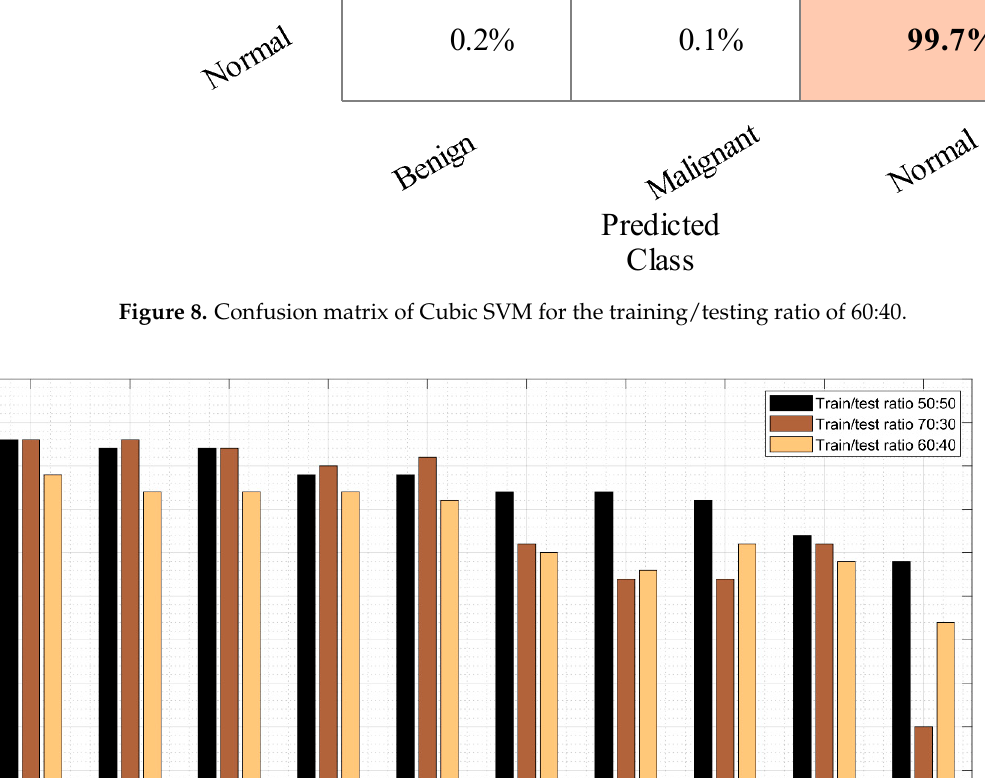
Figure 9. Summary of DarkNet53 classification accuracy using different training/testing ratios. Table 5 presents the results of the fourth experiment. In this experiment, a 50:50 training/testing ratio is used. The best features are selected using the binary DE method. The 99.1% accuracy is achieved by Cubic SVM after feature selection. A few other pa- rameters are also computed for this classifier, such as sensitivity rate, precision rate, F1 score accuracy, FNR, and time complexity, and their values are 99.1%, 99.06%, 99.08%, 1, 0.9 and 16.082, respectively. The confusion matrix of Cubic SVM is illustrated in Figure 10. The computational time of each classifier is also noted, and the best time is 28.082 (s) for the CSVM classifier, and the worst time is 42.829 (s) for the WKNN classifier. This shows that the computational time after the selection process is significantly minimized compared with the time given in Tables 2 and 3. Table 5. Classification results of binary differential evolution selector using ultrasound images, where the training/testing ratio is 50:50. Classifier